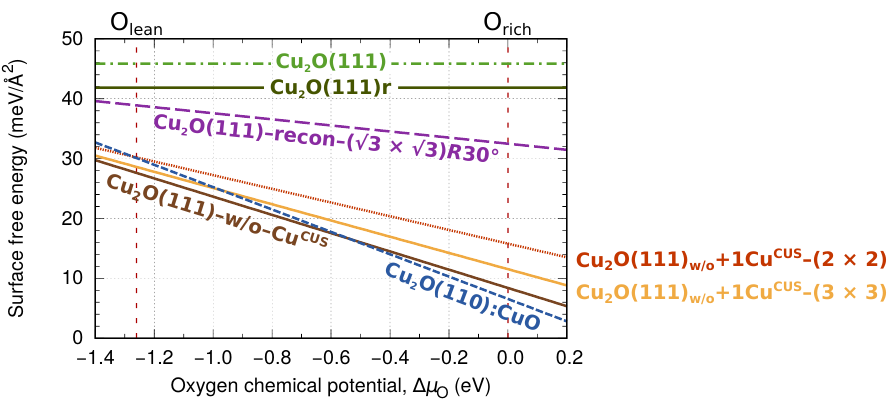
Figure 2. PBE calculated surface free energies for the considered Cu 2 O surfaces as a function of the oxygen chemical potential, Equation (13). The O lean and O rich labels mark the oxygen-lean and oxygen-rich limits, respectively. The corresponding surface structures are depicted in Figure 1; see also Figures 1 and 2 in Part I